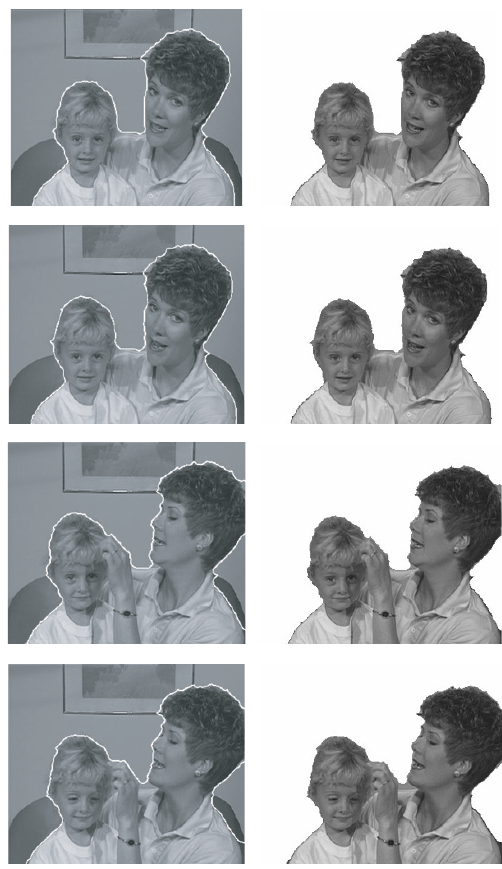
Figure 2: Mother and Daughter: final contours in white and ex- tracted video objects.